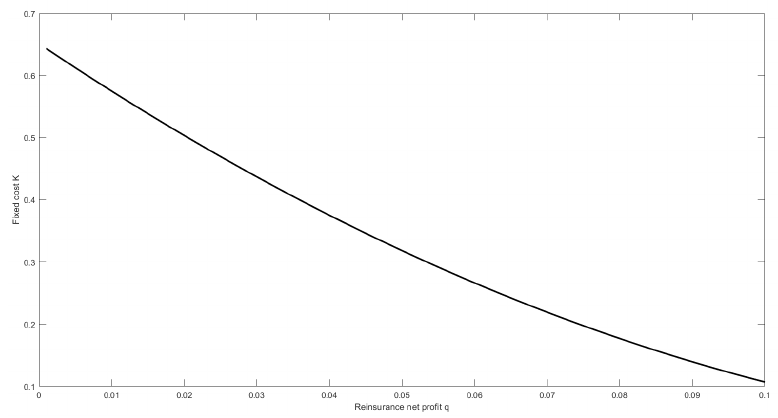
Figure 1. The effect of the reinsurer’s net profit q on K ∗ .